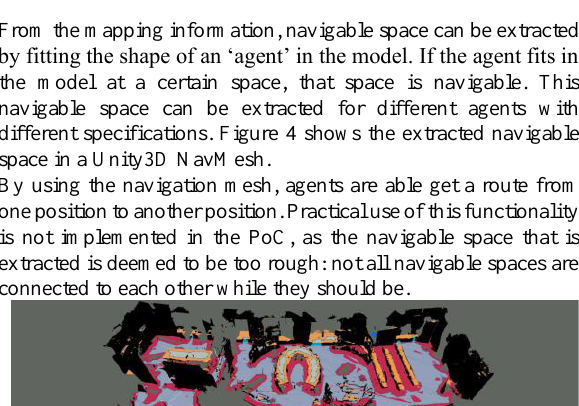
Figure 3: Object oriented visualization. Orange: obstructive objects. Black: walls. Red: floors